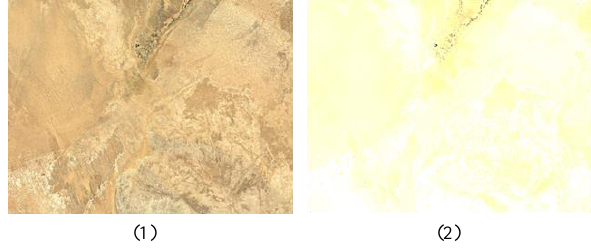
Figure 4: (1) LuxCarta downscaled 8bit, (2) ESA downscaled 8bit.